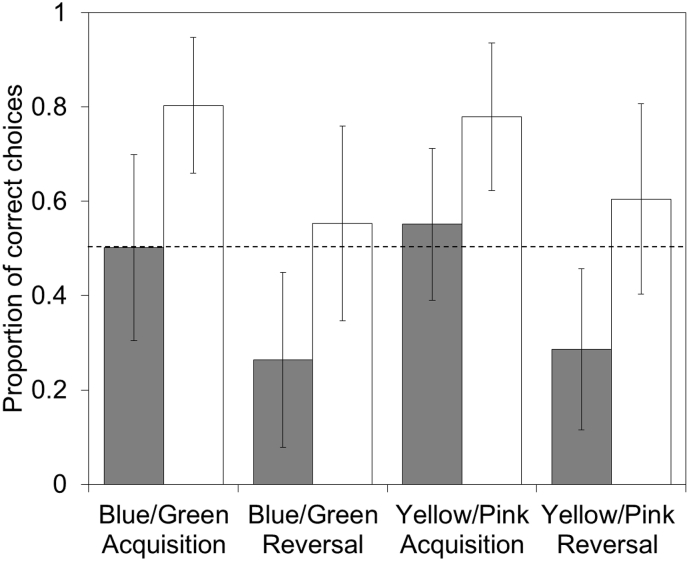
Differences in the mean proportion of correct choices made by individuals in their first (grey bars) and last (white bars) set of ten choices in a set of acquisition and reversal tasks with binary choices based on two sets of colour cues. The dashed line indicates 50% random choice. Error bars indicate ±1SD.